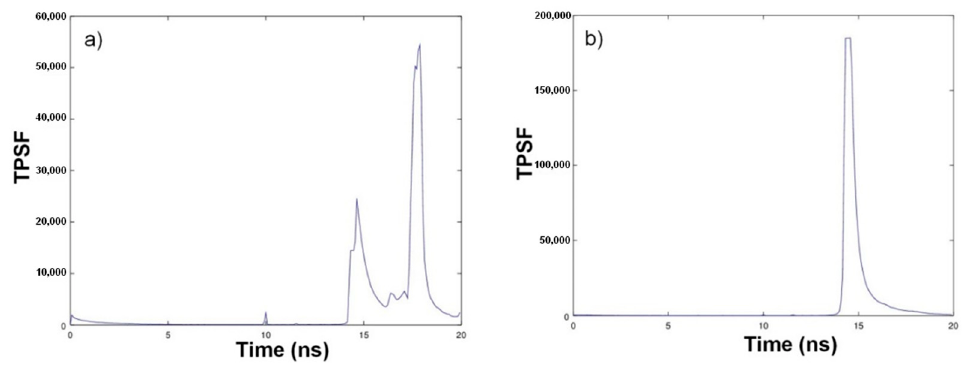
Figure 8. Number of collected photons as a function of time ( a ) @ 0.01 g/L; ( b ) @ 0.3 g/L. For a low concentration of kieselguhr (0.01 g/L), one can see two distinct parts in the temporal profile (Figure 8a). The first part, the peak at the left, is the real signal returned